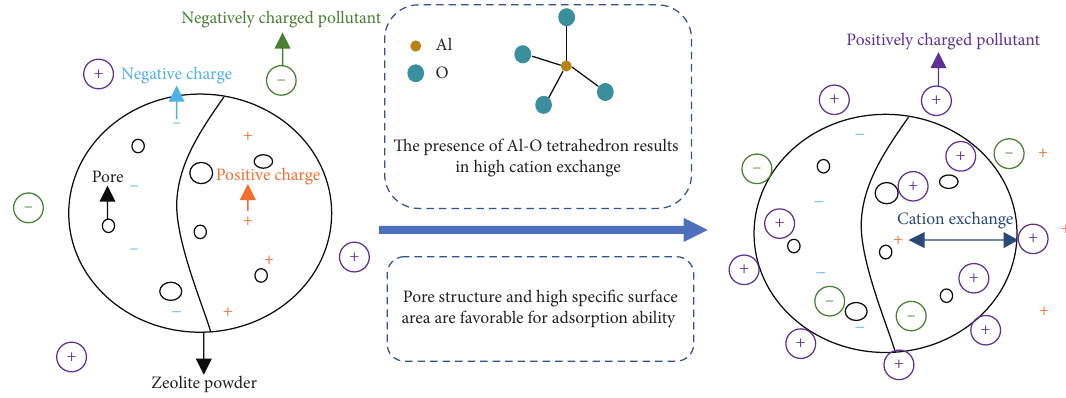
Figure 11: Characteristics of zeolite powder.